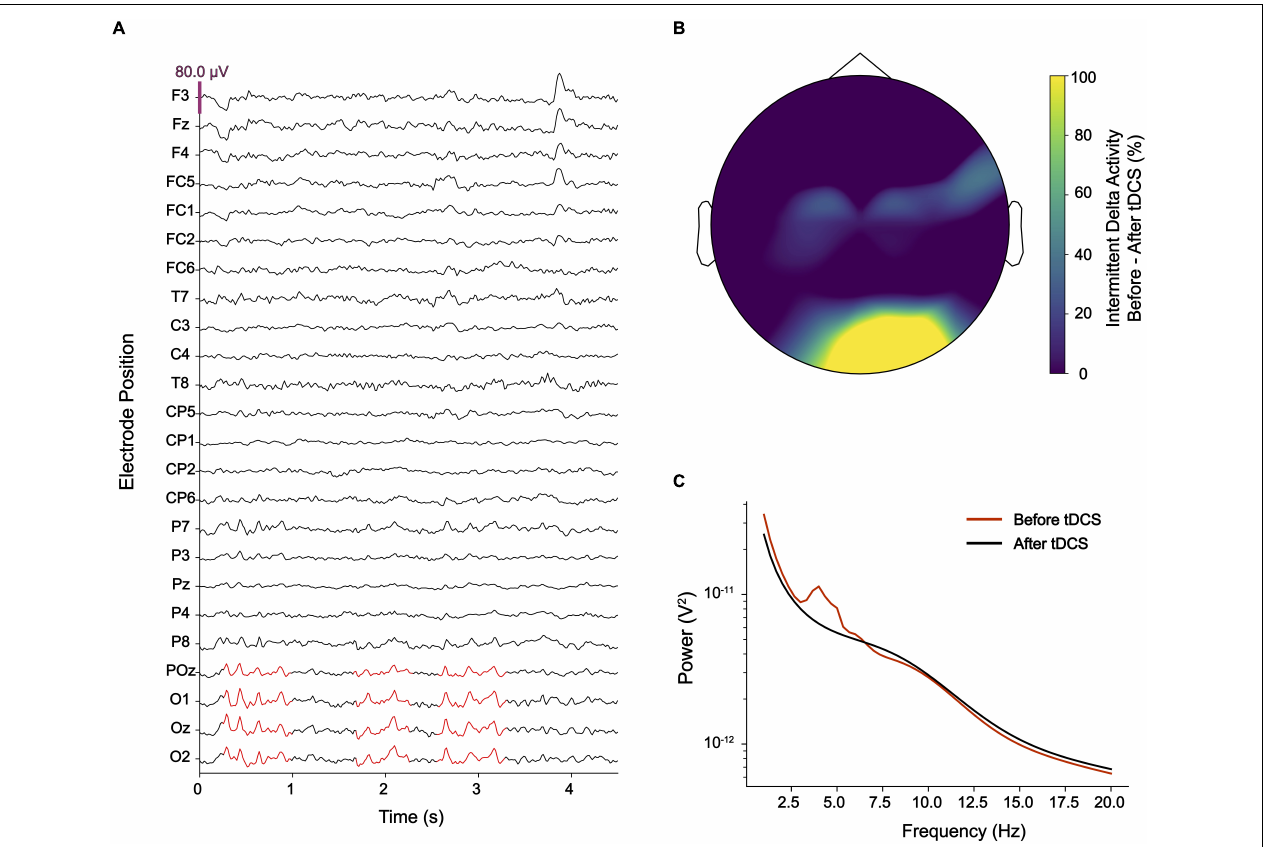
FIGURE 1 | (A) Electroencephalography (EEG) showed intermittent pathological delta activity (marked in red) over occipital electrodes. (B) After delivering cathodal transcranial direct current stimulation (tDCS) over occipital brain regions, pathological delta activity became substantially reduced. (C) While an EEG power-spectrum averaged for occipital electrodes (O1, Oz, O2, and POz) showed a clear peak at ∼ 4 Hz, this peak disappeared after cathodal